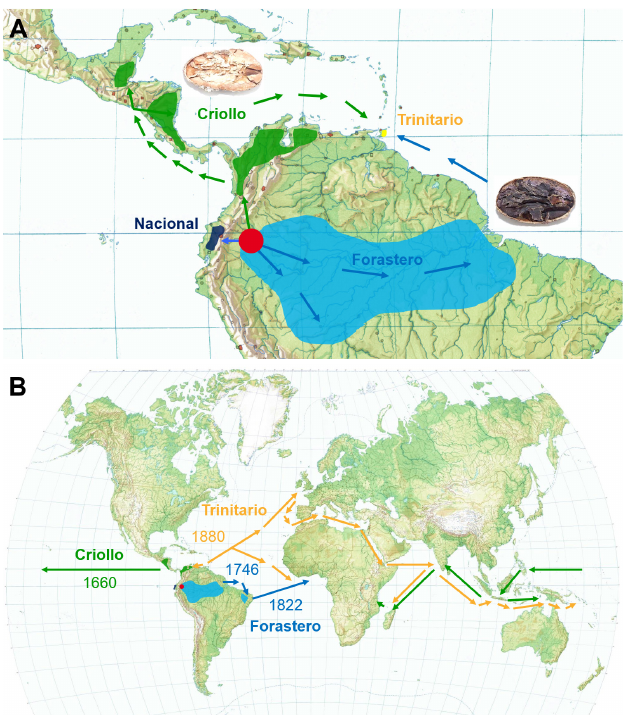
Fig. 1: Historical distribution of the cacao tree ( Theobroma cacao L.) in the Americas (A) and Worldwide (B) modified from r ohsius (2007). Red dot: Center of Origin. (Map: http://www.reliefs.ch/blasse_welt - karte.jpg . Iimages of cocoa taken from r ohsius